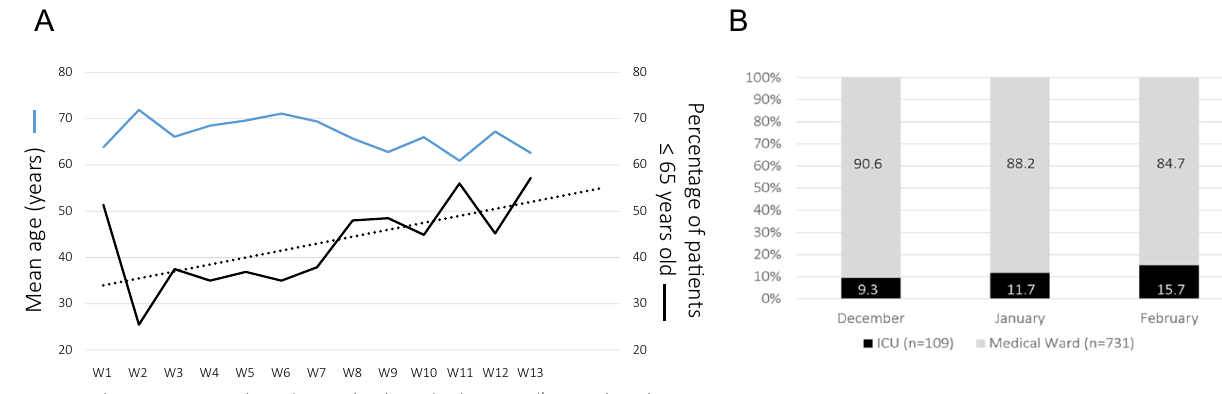
Figure 1. Age change and hospital admission after ED, over a 3 months-period. ( A ) Mean age (blue line) and percentage of patients under 65 years old (black line, F-test 7.24, p = 0.021—dotted line, R-value = 0.6301) over